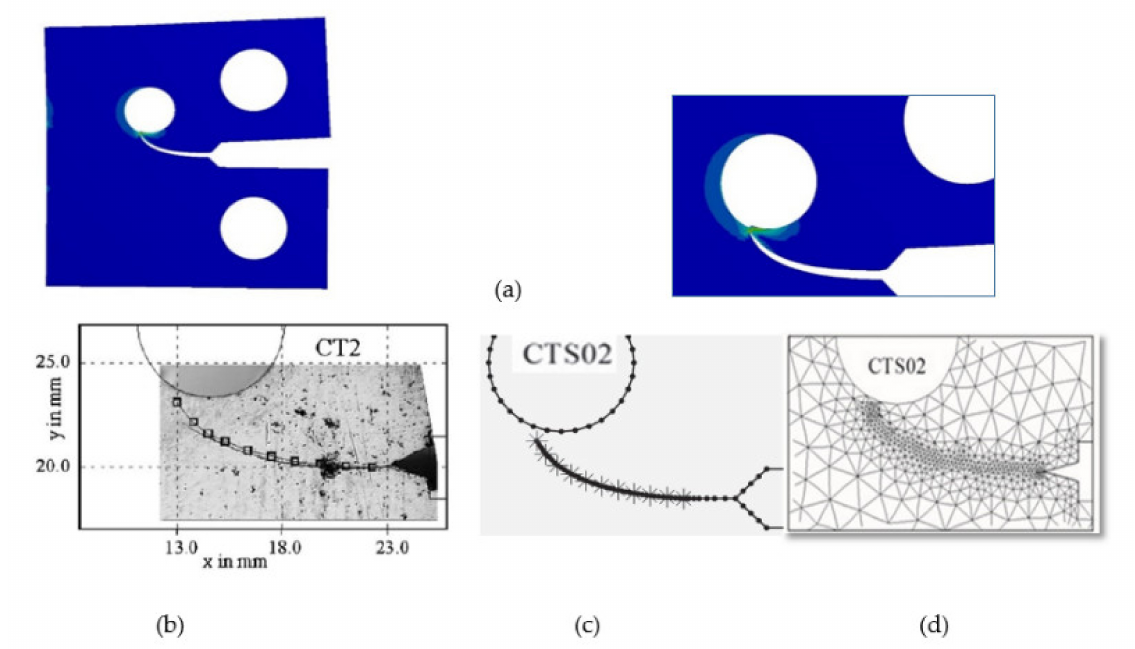
Figure 7. The predicted crack path of CTS02 ( a ) present study, ( b ) experimental and numerical results of [24], ( c ) BemCracker2D [41] and ( d ) Quebra2D